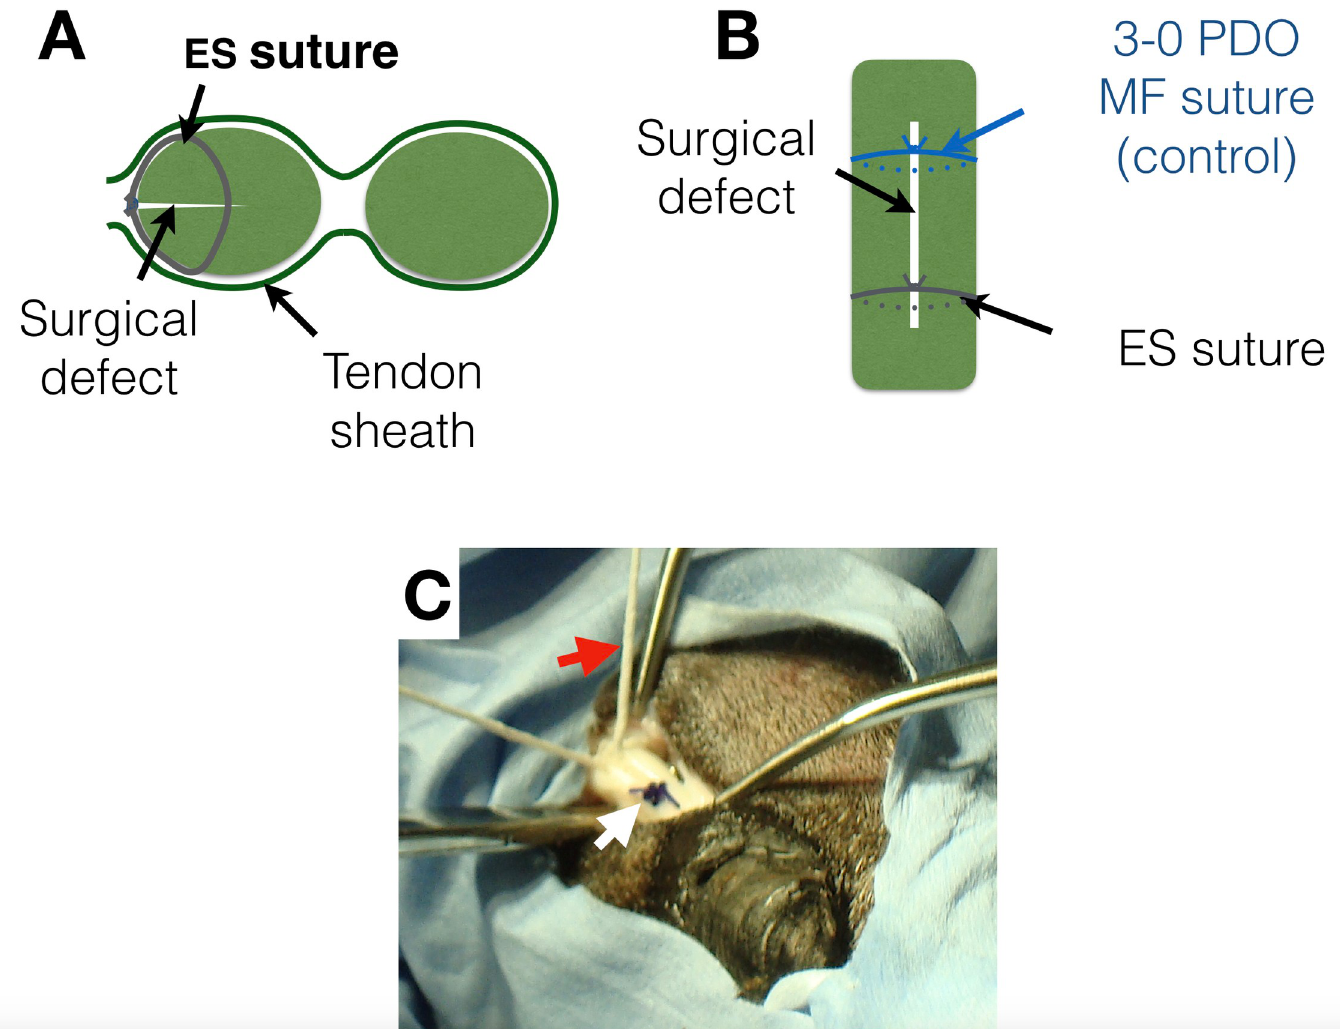
Fig 1. Electrospun (ES) suture and monofilament (MF) suture repair in an ovine model. A) Schematic diagram showing the transverse section of the deep digital flexor tendon (DDFT) repair model. B) Schematic diagram showing lateral view of the defect in the DDFT repaired with the MF suture (control) and the ES suture. C) Digital photograph showing surgical repair of the DDFT defect showing the ES suture (red arrow) and MF suture (white arrow).